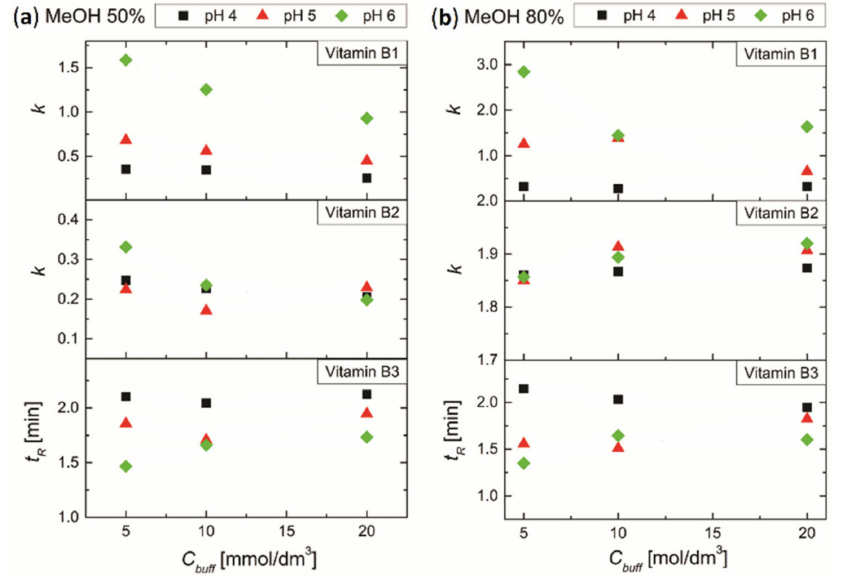
Figure 11. Effect of buffer pH and concentration on retention of vitamins in column A (Acclaim™ Mixed–Mode HILIC 1) with: ( a ) 50% and ( b ) 80% content of methanol in mobile